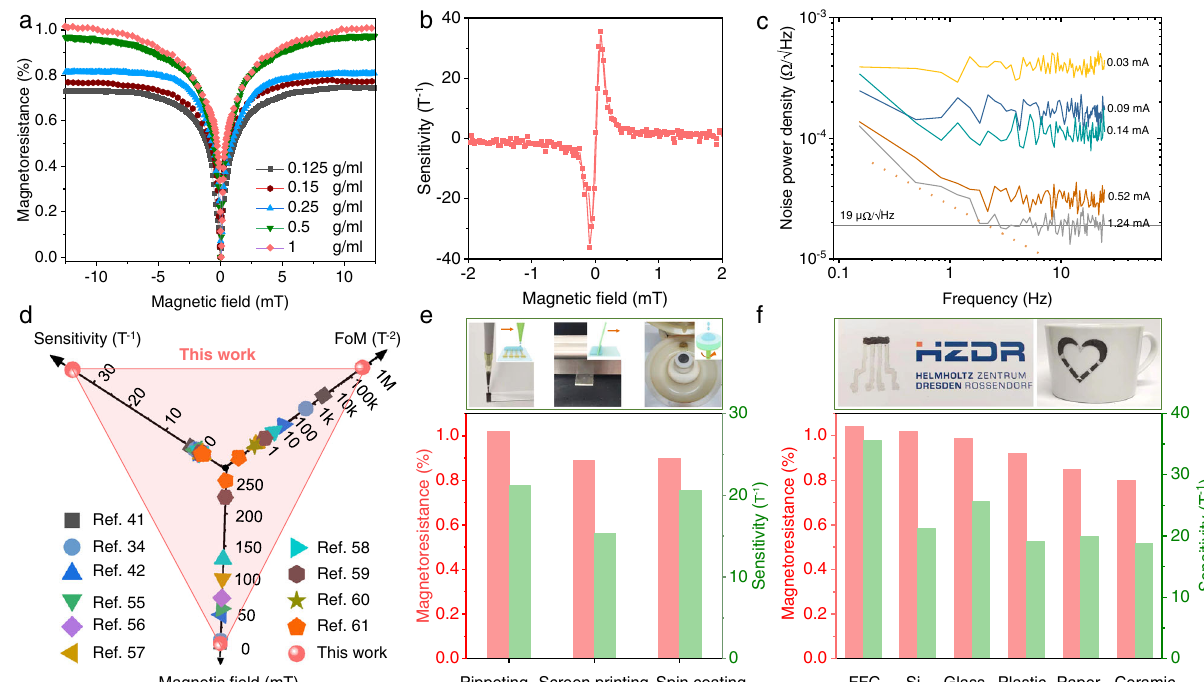
Fig. 2 | CharacterizationofAMF-mediated printablemagnetoresistivesensors. a Magnetoresistance of sensors made by composites of different Ni 81 Fe 19 micro- particle concentrations. b Magnetoresistive sensitivity of sensor of 1g/ml con- centration. Sensitivity was calibrated by the fi rst derivative of electrical resistance with respect to magnetic fi eld of magnetoresistive element divided by resistance. c Noise signal of sensor. d Comparison of sensitivity, magnetic fi eld where the highest sensitivity is obtained, and fi gure of merit (FoM) for printable